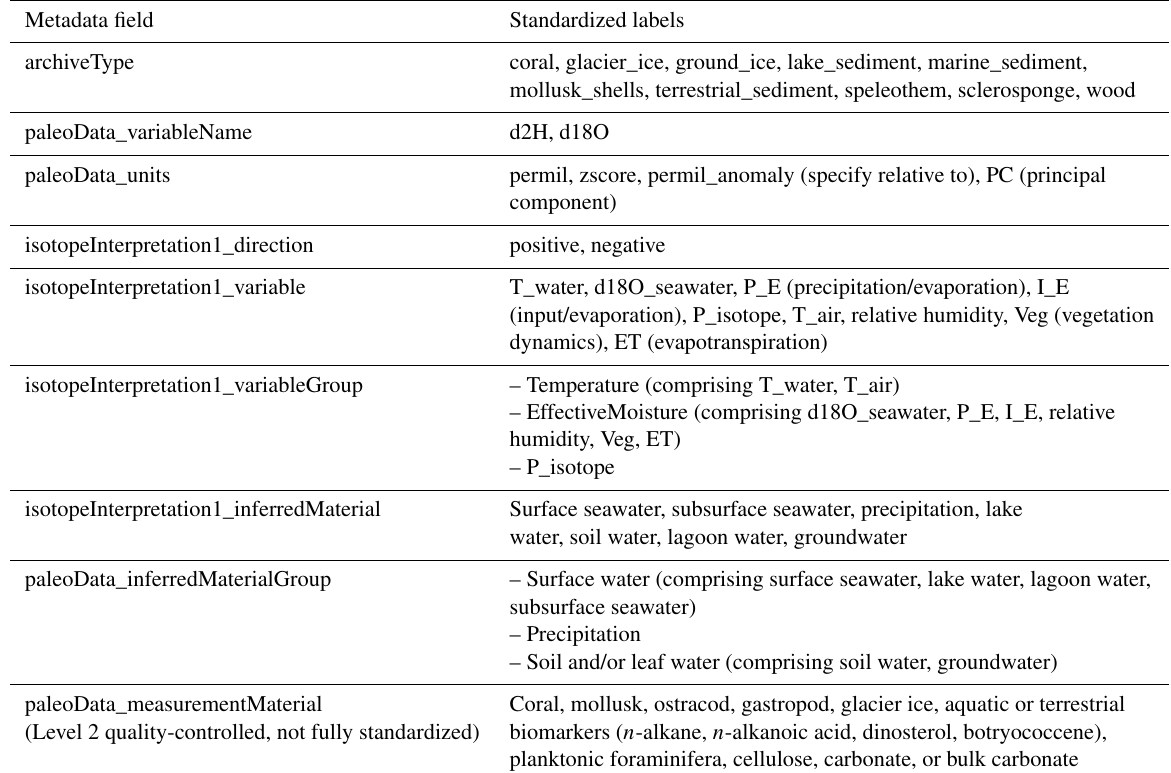
Table 7. Standardized controlled vocabulary options for metadata fields in the Iso2k database (standardized labels show labels used in Iso2k Database, and parentheses expand any